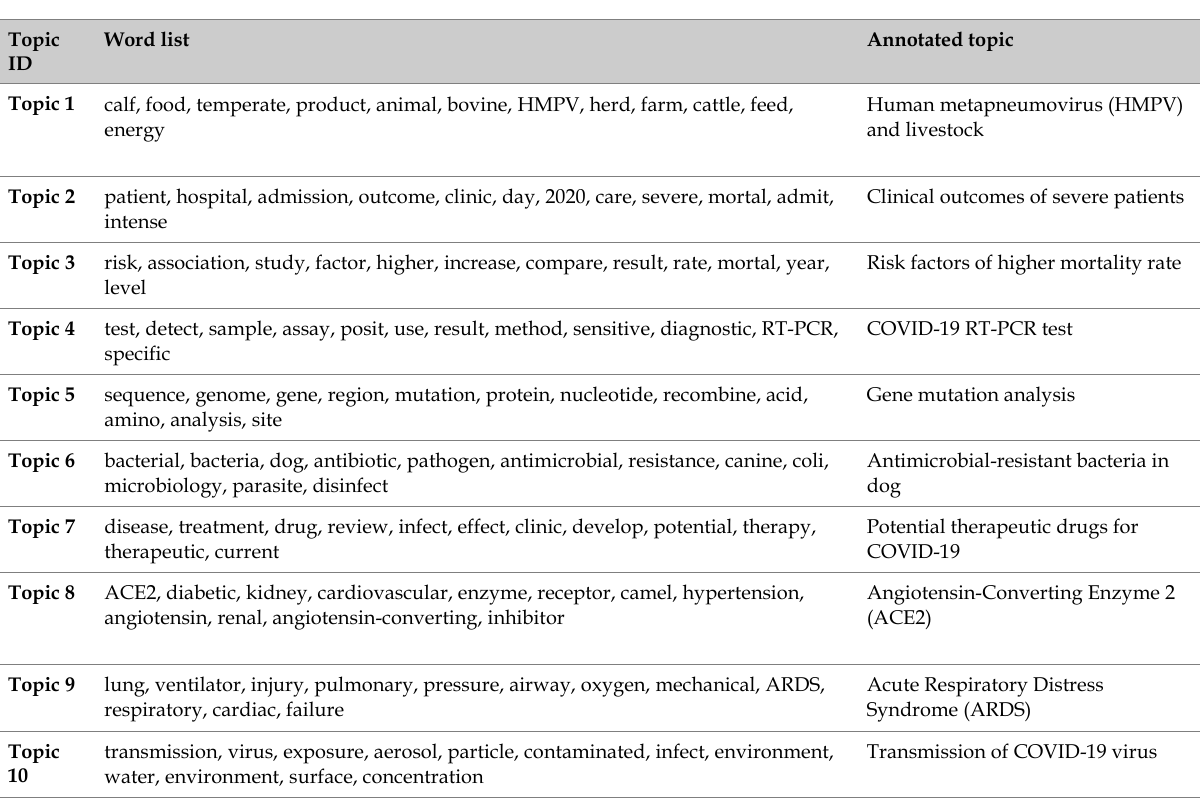
Table 4 Global topics inferred from the entire CORD-19 dataset Topic